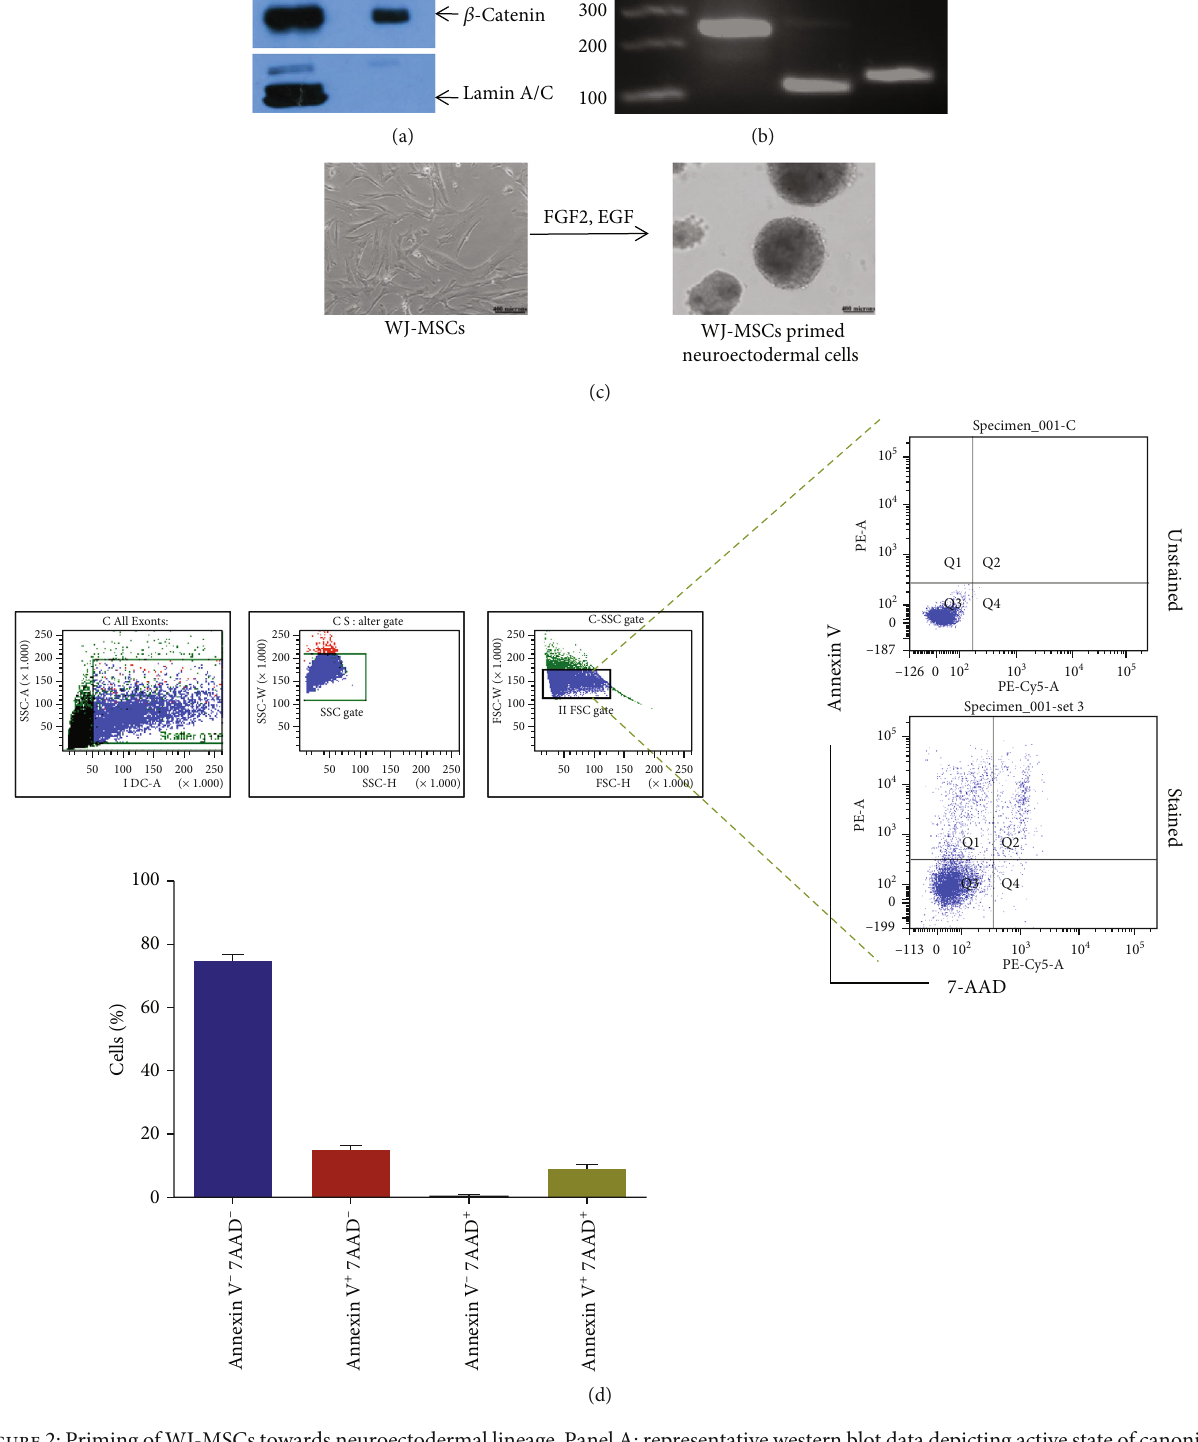
Figure 2: Priming of WJ-MSCs towards neuroectodermal lineage. Panel A: representative western blot data depicting active state of canonical Wnt signaling as demonstrated by the presence of β -catenin in the nuclear extract. Panel B: representative RT-PCR data depicting the expression of FGF and EGF receptors in WJ-MSCs. Panel C: generation of potential neuroectodermal cells in the form of spheres (free fl oating clusters of cells) as observed upon induction with cocktail of FGF2 and EGF. Scale bar ~ 400 μ m. Panel D: gating strategy followed to analyzing viable, nonviable, and apoptotic neuroectodermal cells in fl ow cytometry analysis. Percentage of viable and nonviable cells are shown below ( mean ± SEM , n = 3